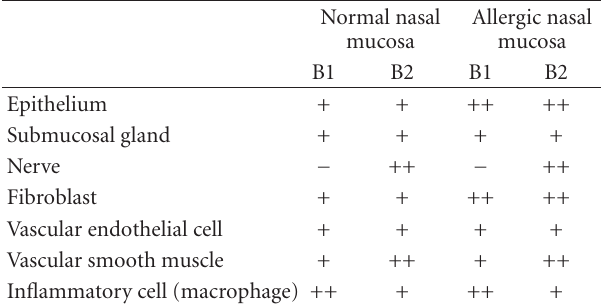
Table 2: Distribution pattern of B1 and B2 receptors in normal and allergic nasal